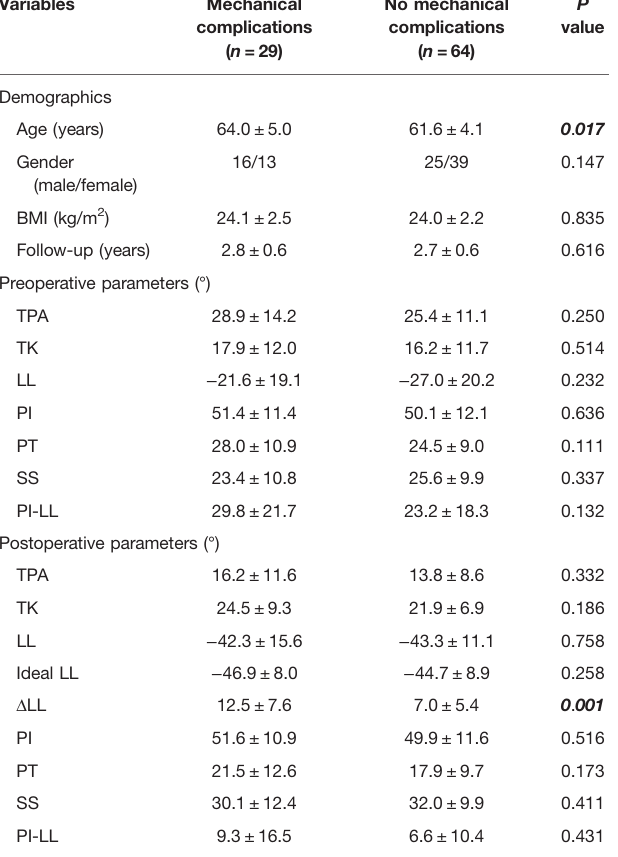
TABLE 5 | A comparison of the demographics and spinopelvic parameters between patients with and without mechanical complications. Variables